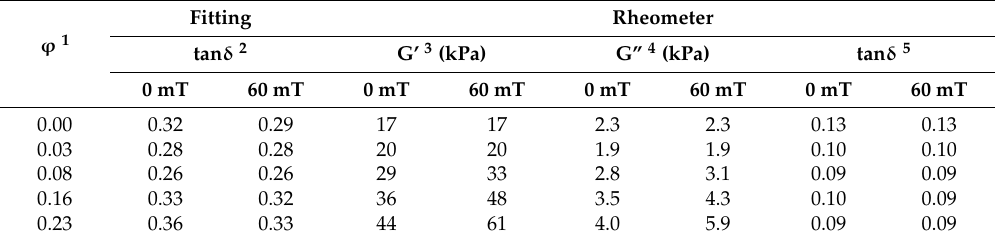
Table 1. Loss factor tan δ determined from transmissibility spectra (loading weight 69 g), storage modulus G’, loss modulus G” , and loss factor tan δ determined from rheological measurement for polyurethane and magnetic elastomers.